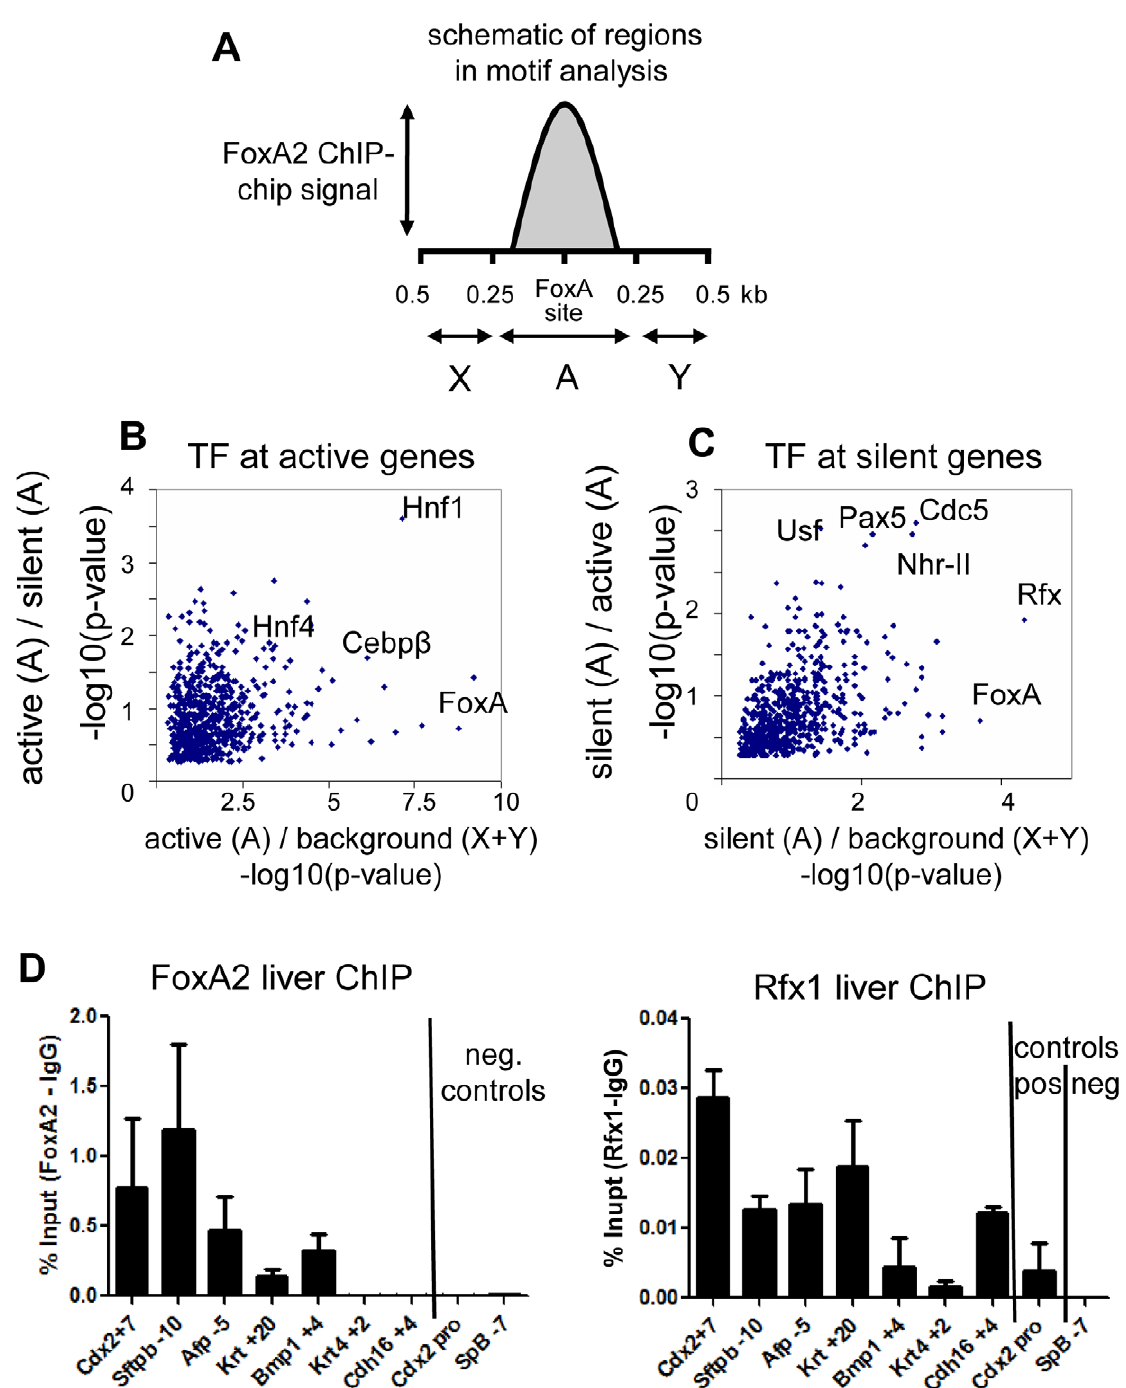
Figure 2. FoxA co-interacting factors. (A) Schematic representation of the ChIP-chip signal at a FoxA bound site, with the FoxA element taken as position 0. Region ‘‘A’’ is the 250 bases flanking the FoxA site and is considered the foreground in motif analysis. Regions ‘‘X’’ and ‘‘Y’’ are the flanking sequence 250-500 bases form the FoxA site and constitute the background. (B) Two-dimensional motif significance of active genes. Each point is a motif with –log10(p-value) shown. X-axis is the p-value from foreground (region ‘‘A’’) vs background (region X + Y) comparison. The Y-axis is the p-value from comparison of motifs in region A for active genes compared to region A for silent genes. (C) Two-dimensional motif significance of silent genes. The X-axis is as described for panel B. The Y-axis is the p-value from comparison of motifs in region A for silent genes compared to region A for active genes. (D). ChIP against FoxA2 and Rfx1 at selected sites expressed as signal after subtraction of IgG control (n=3). SpB -7 serves as a negative control site.